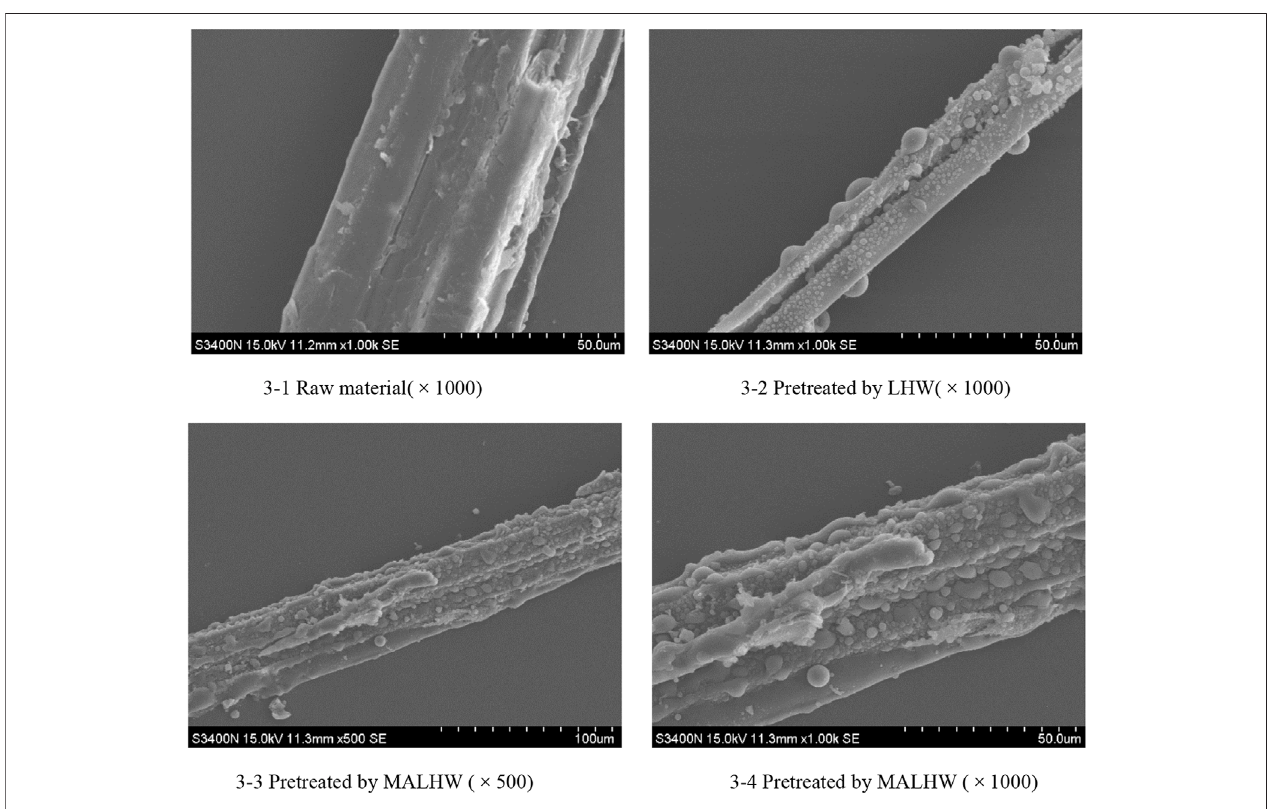
FIGURE 3 | SEM picture of Moso bamboo pretreated by different methods.